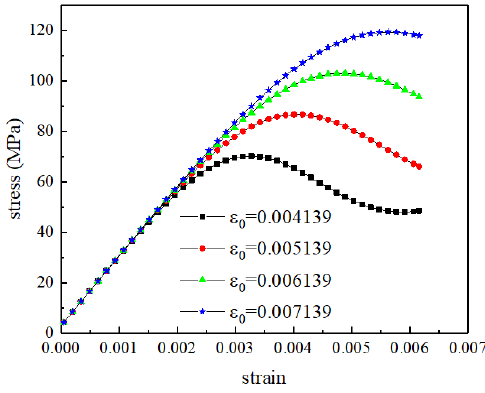
Fig. 5 The influence of the parameter ε 0 on the constitutive model.